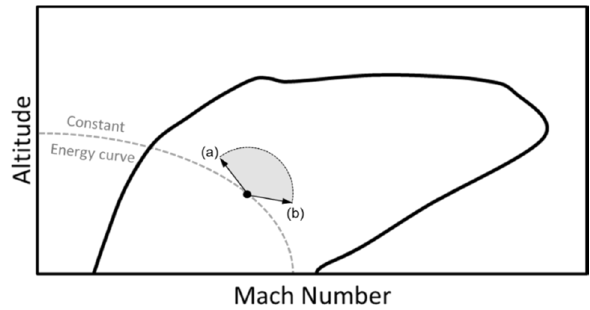
Figure 3. Schematic representation of feasible transitions in the h-M plane by means of flight path angle control (shaded area). Limits (a) and (b) correspond to a vertical climb and a vertical descent, respectively.